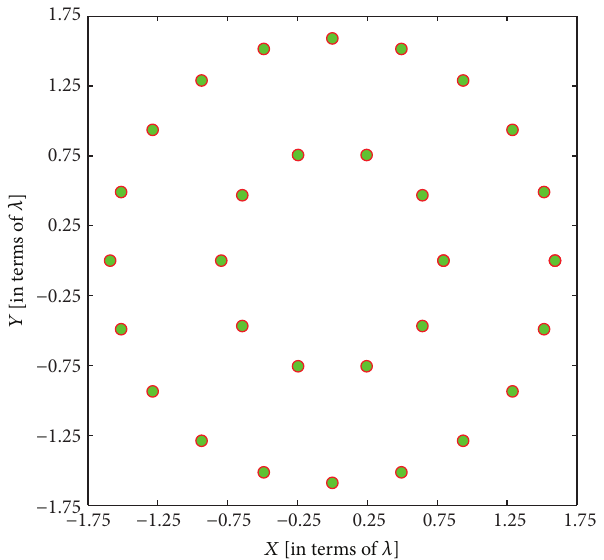
Figure 1: Concentric ring array of isotropic antennas in 𝑋 - 𝑌 plane.